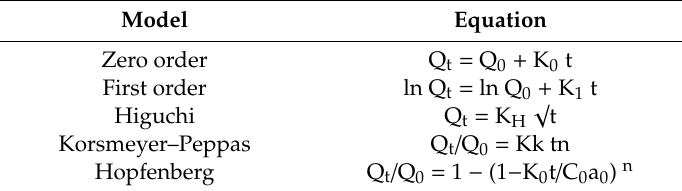
Table 2. Kinetic models to investigate the kinetics of